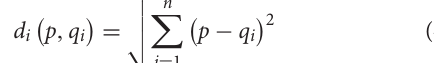
FIGURE 2 | Image of cabbage